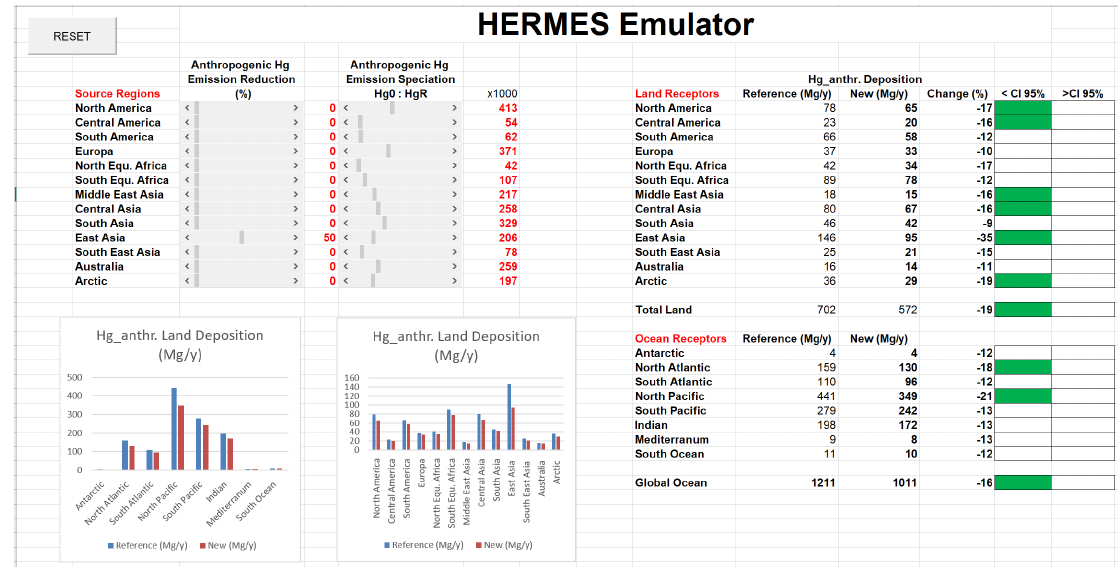
Figure 5. Use-case 3: Hg